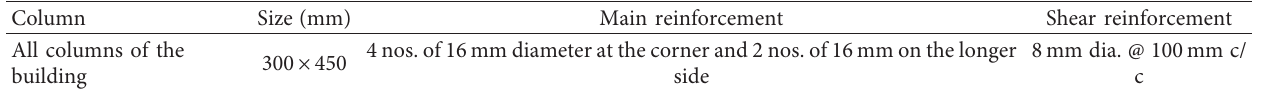
Table 3: Column dimensions and detailing.